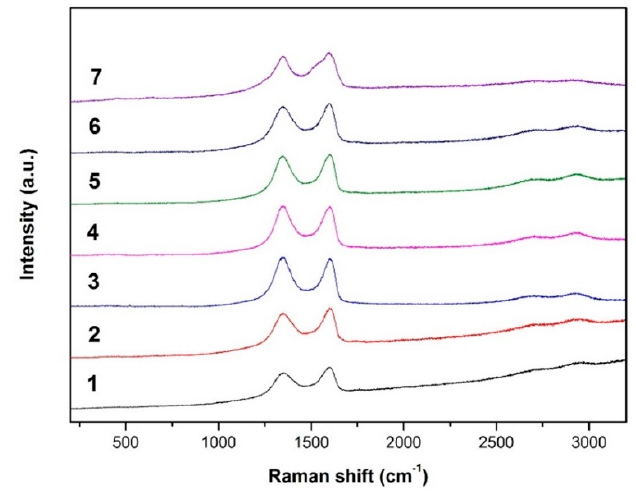
Figure 2. Changes in Raman spectra of the GO and rGO samples.